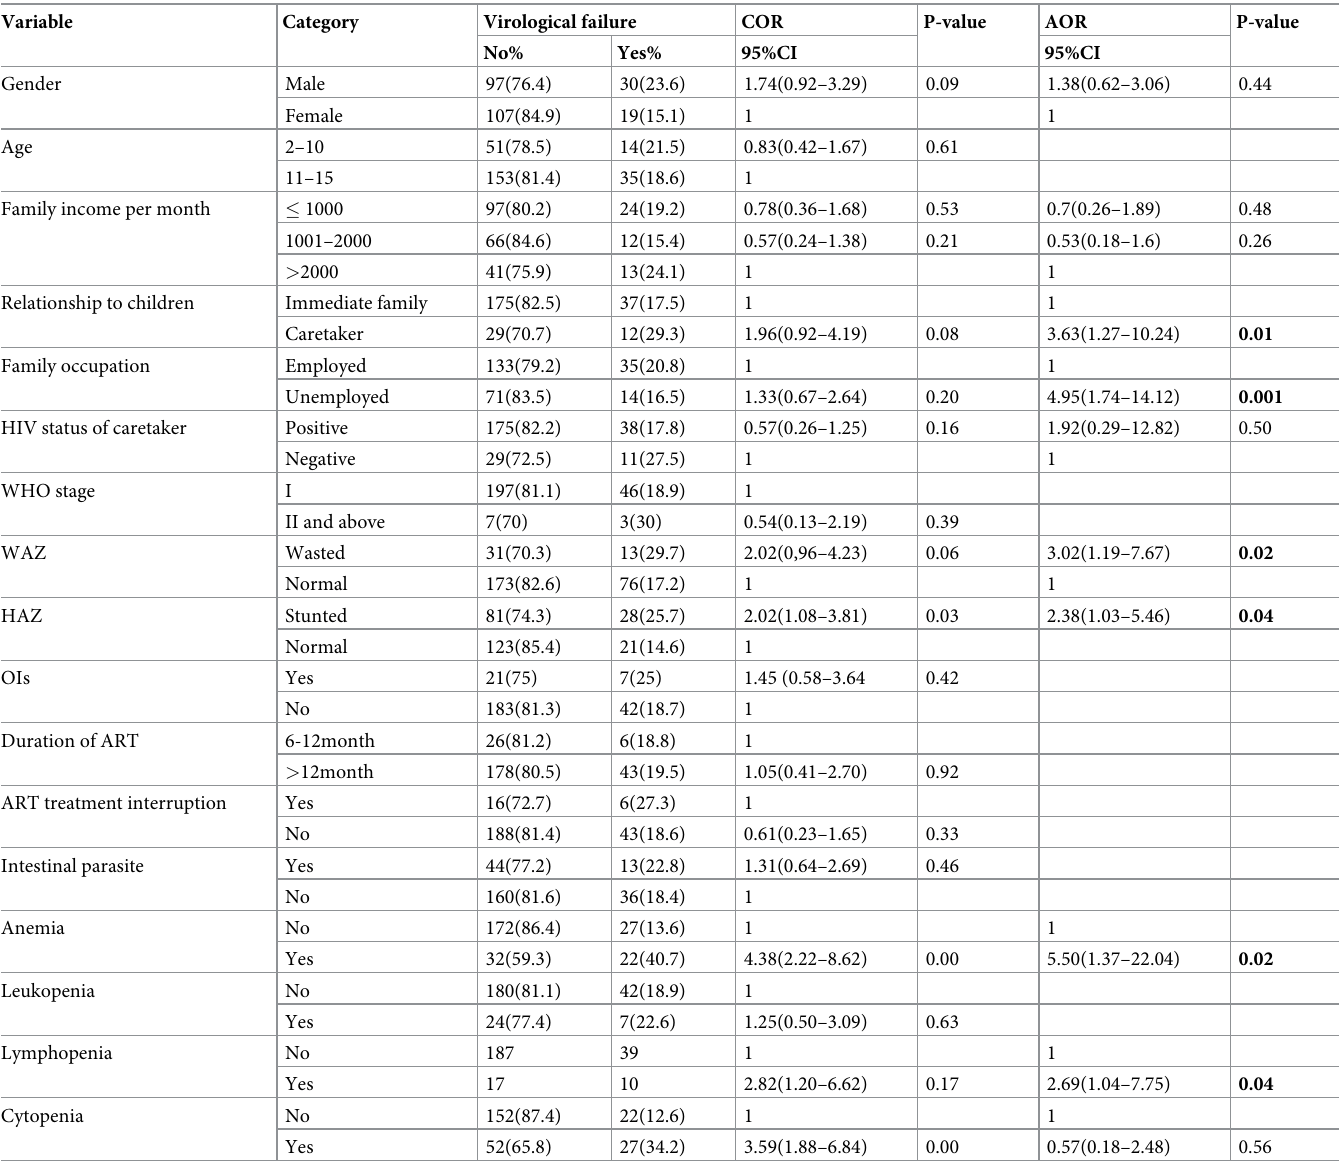
Table 3. Factors associated with virological failure among children on ART attending at UoGCSH ART clinic, Northwest Ethiopia, 2021 (N = 253).